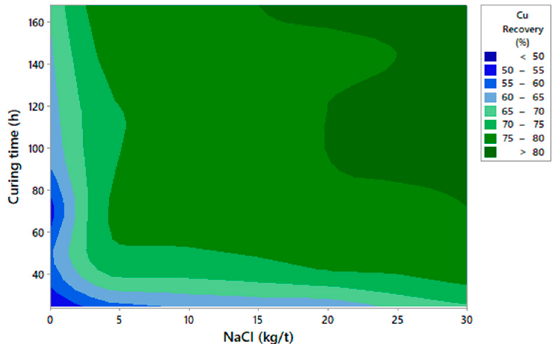
Figure 1. Main effects plot of Cu recovery ( a ) and Mn recovery ( b ) versus curing time (h) and NaCl concentration (kg/t).